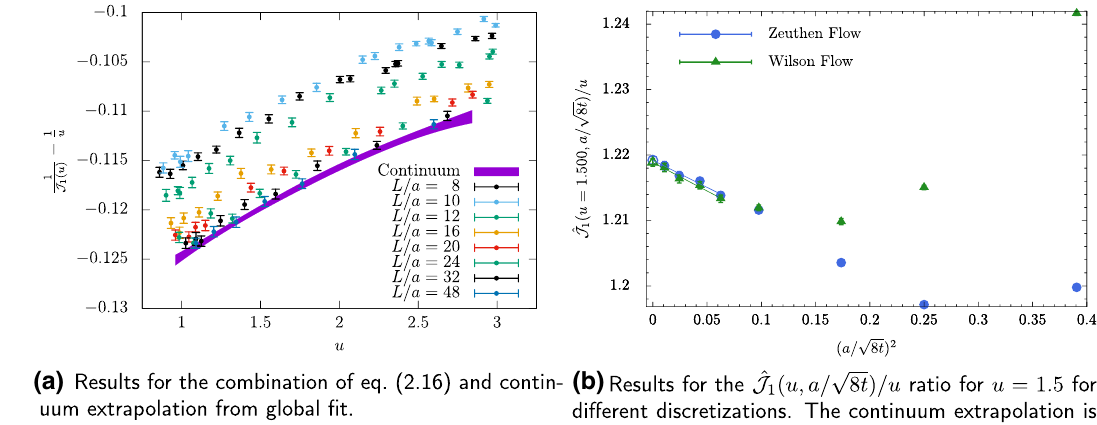
√ 8 t ) function and continuum